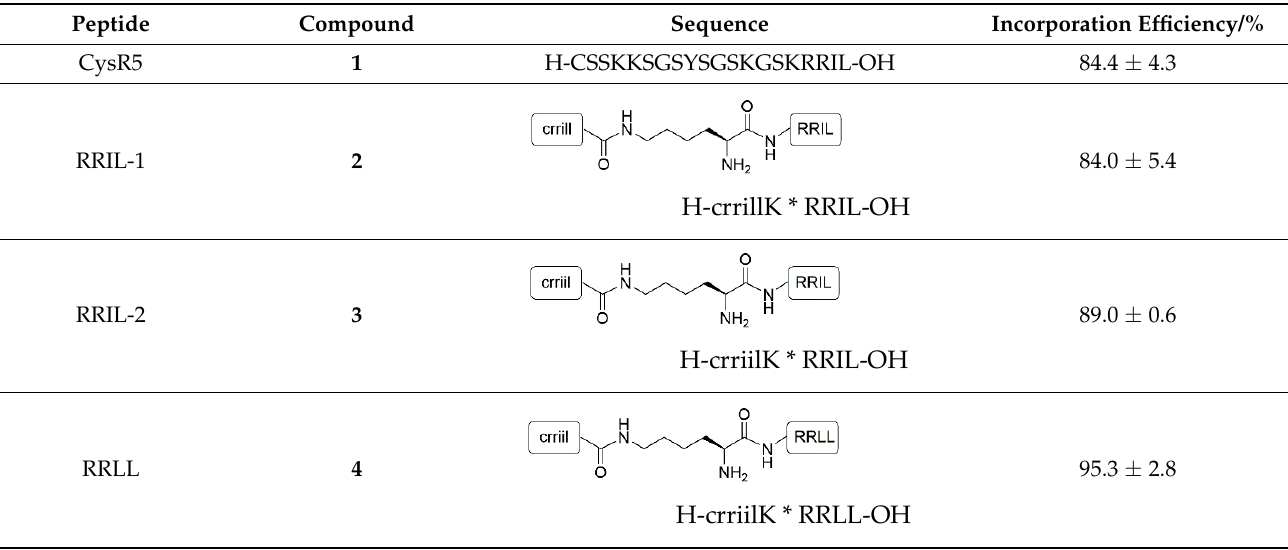
Table 1. Sequences of silica-precipitating peptides and peptide incorporation efficiency. * Indicates branching via the lysine (K) sidechain.